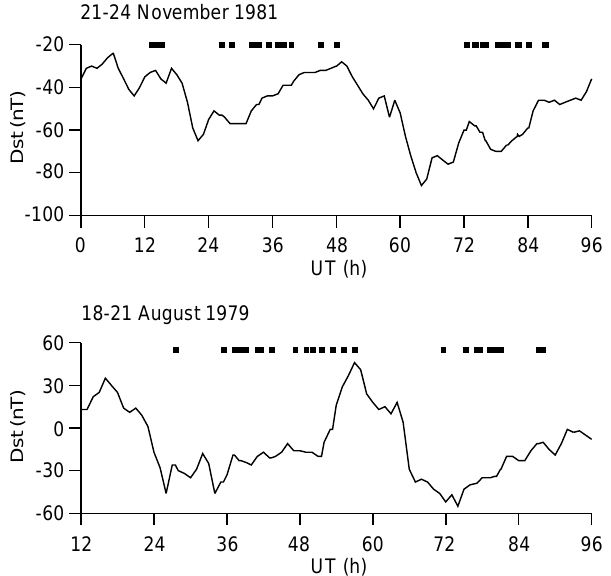
Fig. 7. Relationship between occurrence of the cli(cid:128)-like phenomena and Dst index. The times of cli(cid:128) observations are marked by black 935–1050 Hz. The black solid area represents the